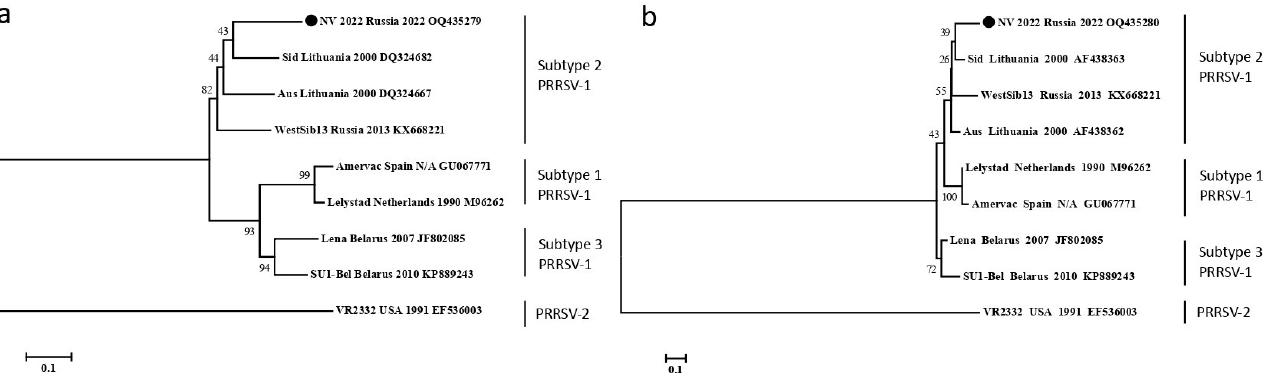
Figure 2. Phylogenetic trees of ORF5 nucleotide sequences ( a ) and ORF7 nucleotide sequences ( b ) of PRRSV strains. Multiple sequence alignments were obtained using the MUSCLE method. Bootstrap confidence limits are shown at each node. The NV 2022 isolate identified in this study is designated by a circle (●). The strain nomenclature is as follows: name, country of origin, year of isolation, GenBank accession number.